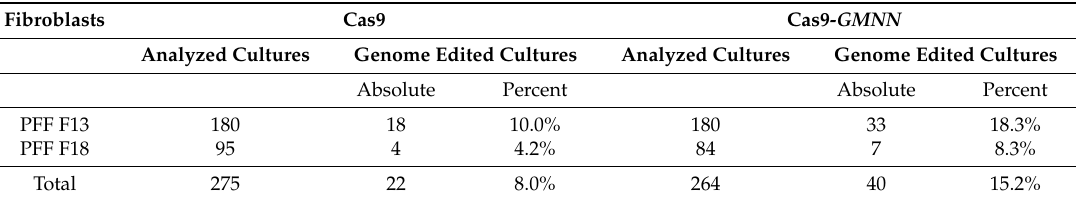
Table 2. Screening of cell cultures for successful genome